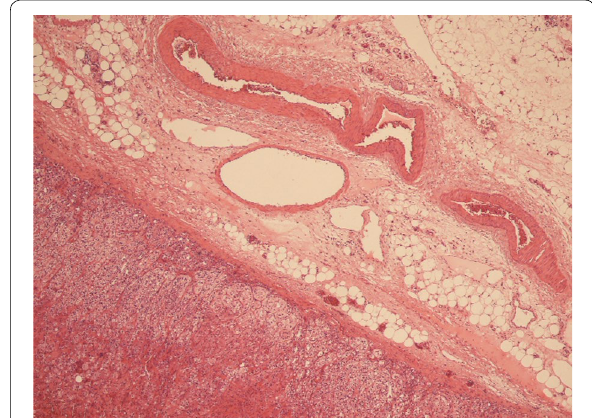
Fig. 2 Adrenal gland with tumour. Haematoxylin and eosin staining ( 4) ×